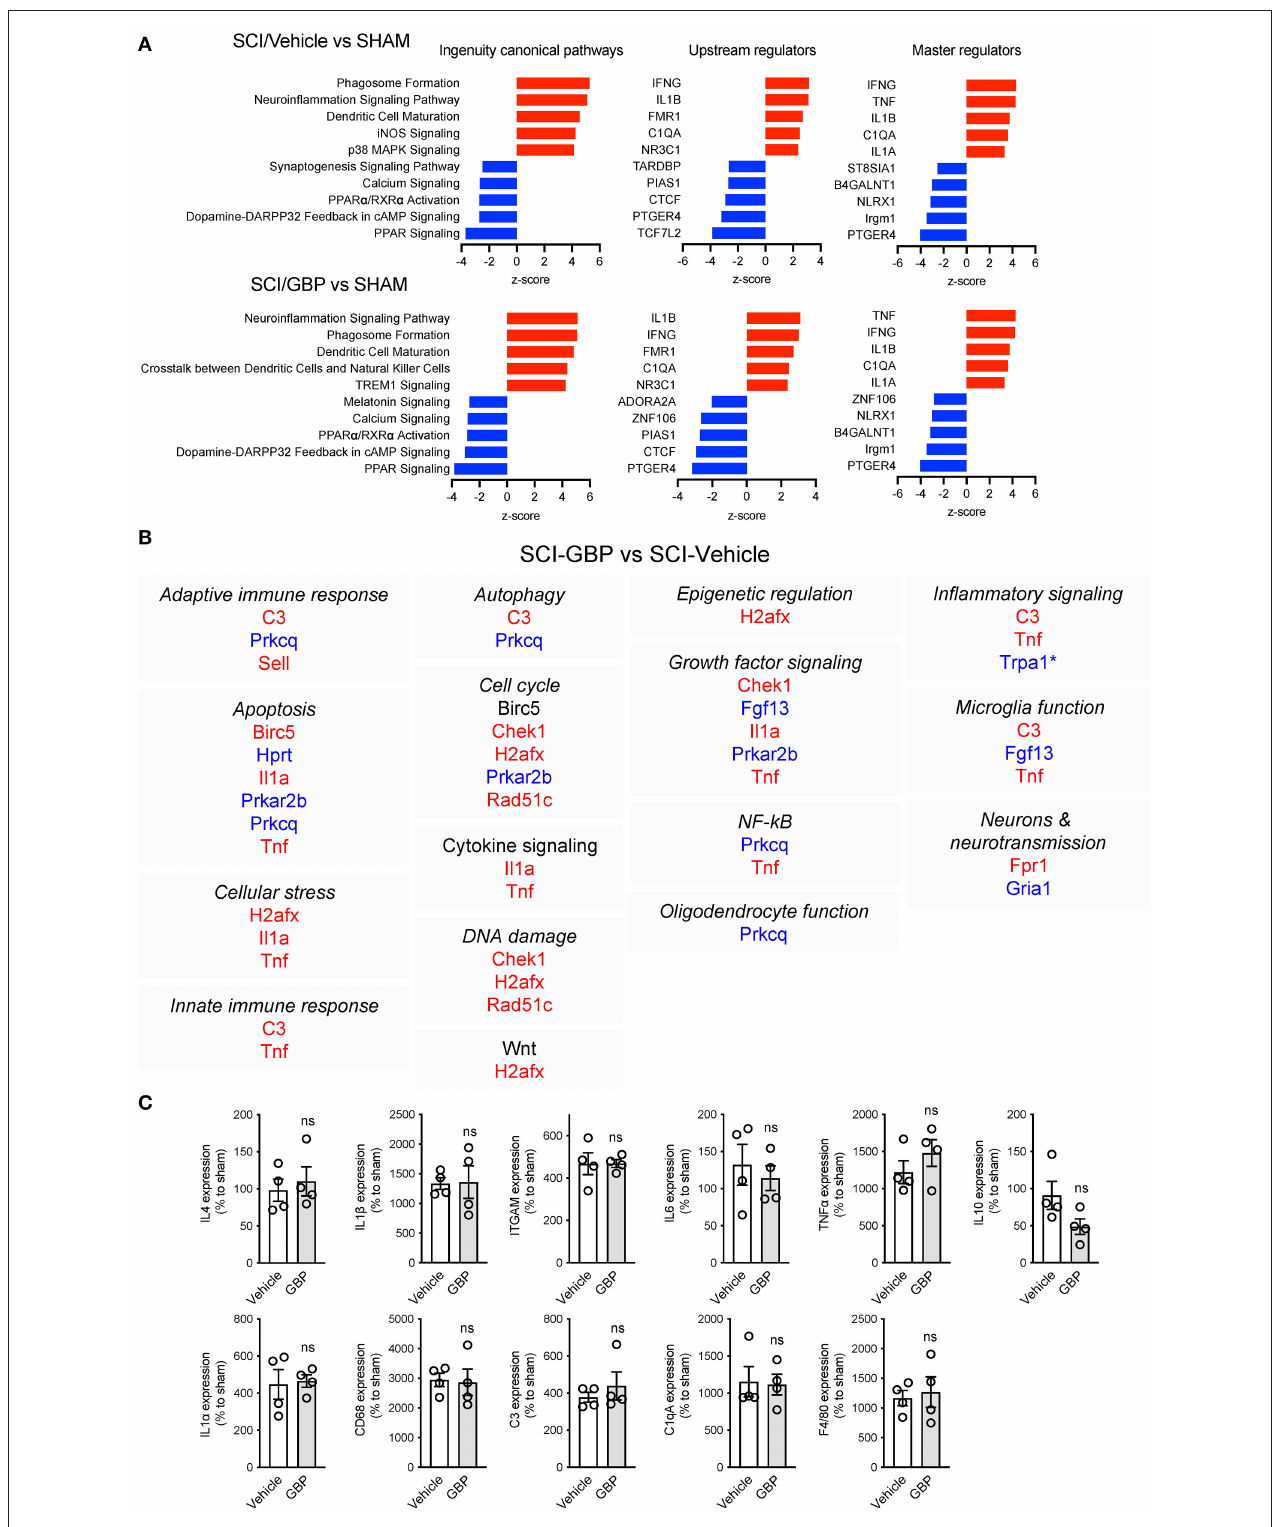
FIGURE 6 | (A) Ingenuity analysis of canonical pathways (z-score, p < 0.05), upstream (z-score, p < 0.05) and master regulators (z-score, p < 0.05) in SCI/Vehicle and SCI/GBP groups. (B) List of GBP-dependent changes in gene expression and associated cellular function. (C) Gene expression of inflammatory markers was analyzed by qRT-PCR. Mean and SEM (Wilcoxon rank sum test, ns: not significant; Sham n = 4, SCI/Vehicle n = 4, SCI/GBP n = 4).